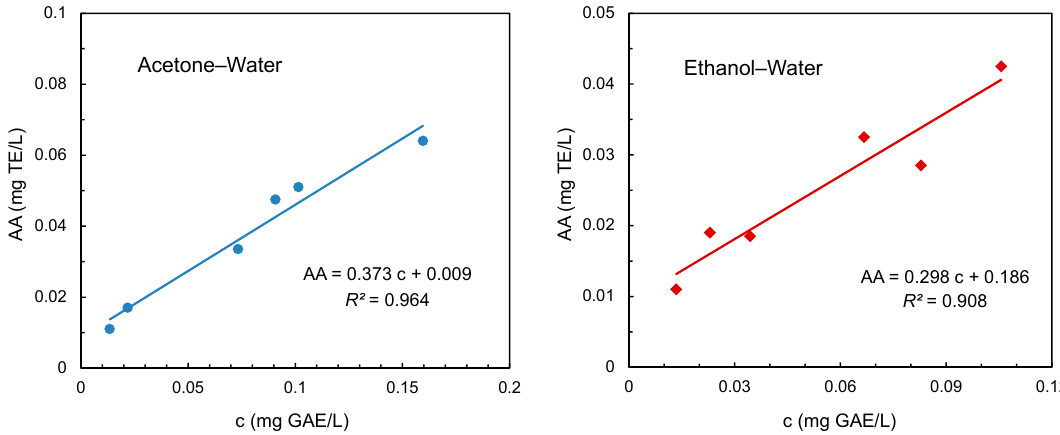
AA = 0.373 c + 0.009 R² = 0.964